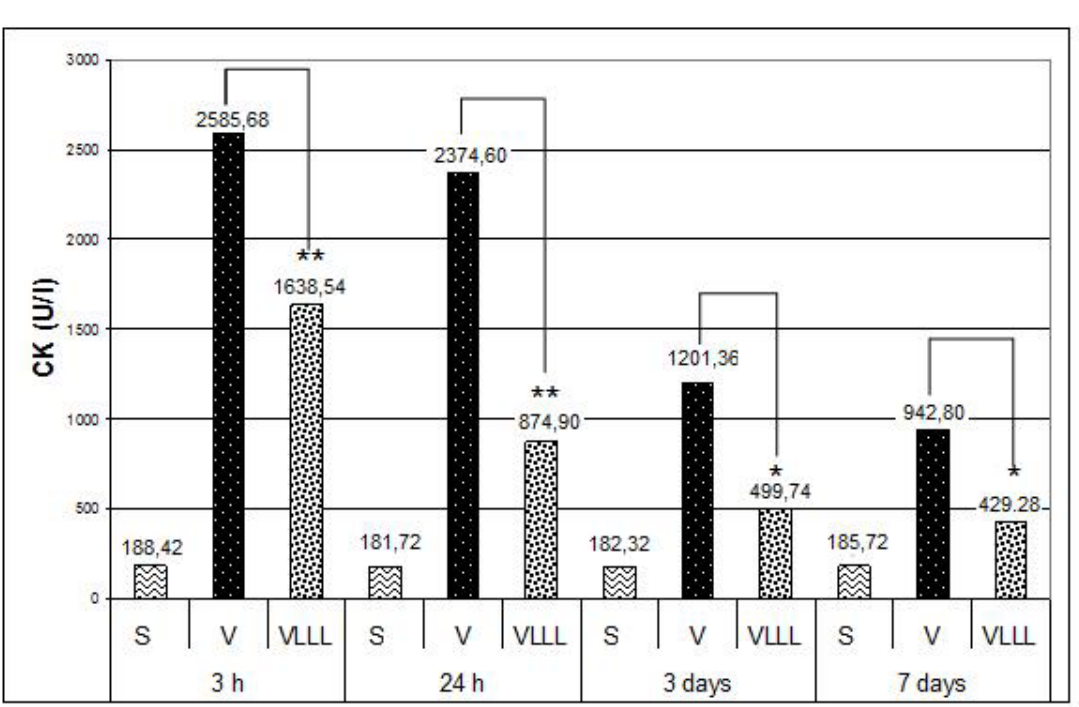
Figure 3 . A bar graph representation of CK-NAC biochemical number in control, venom and GaAlAs venom-plus-laser groups. (S= Sterile group, V= Venom Group, VLLL= Low-Level Laser Group) ** p (cid:148) 0.001; * p (cid:148)